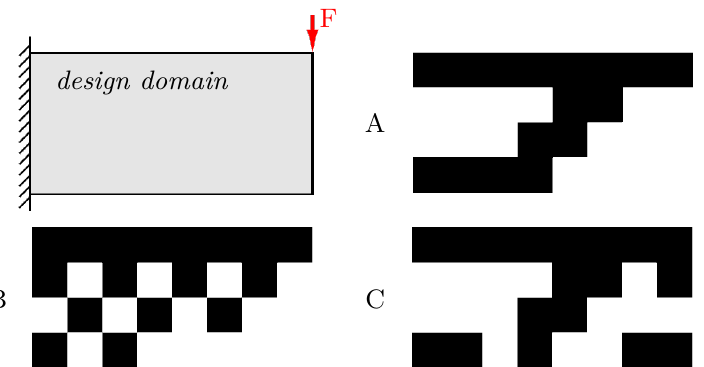
Figure 3. Three binary solutions ( A – C ) to a simple design problem. Domination order is B ≺ n A ≺ n C. Only ( A ) is considered a feasible solution. ( B ) shows checkerboard structures and ( C ) shows material that is not connected to the